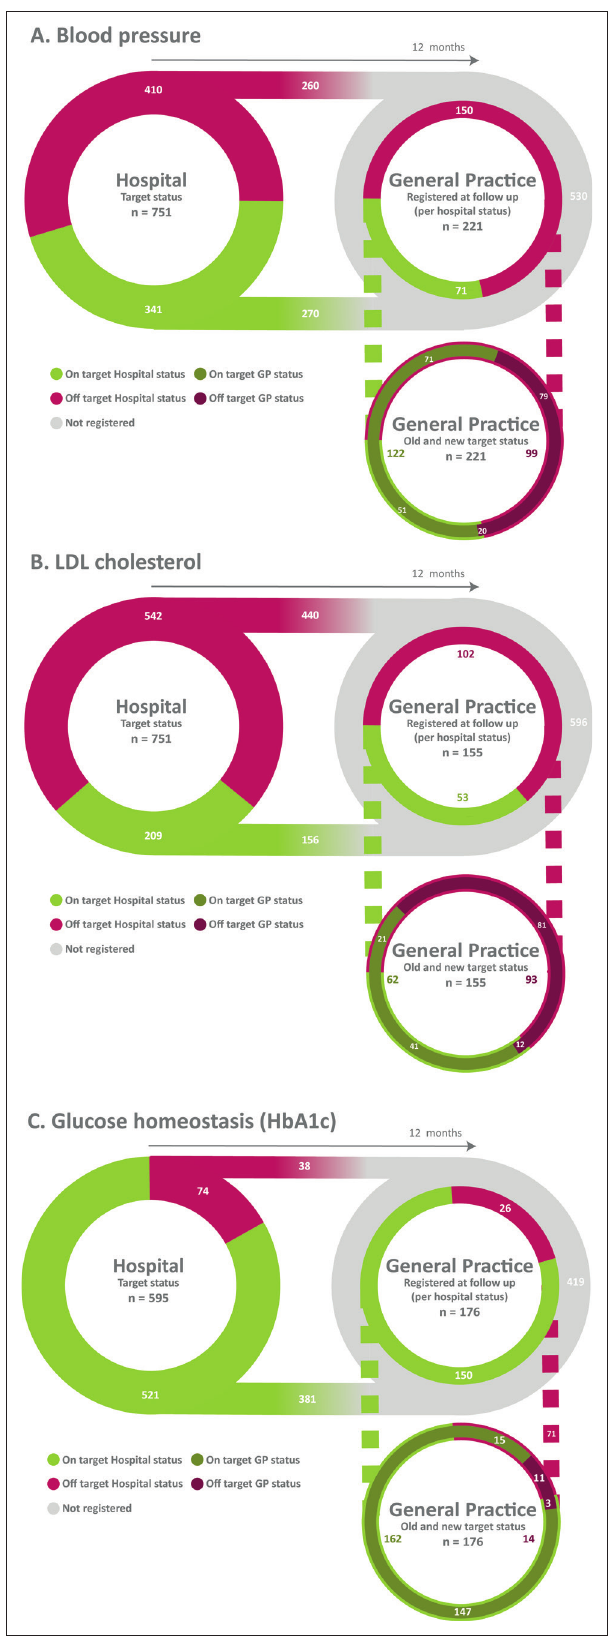
Figure 2 The multidisciplinary care continuum for blood pressure, LDL- cholesterol, and glucose